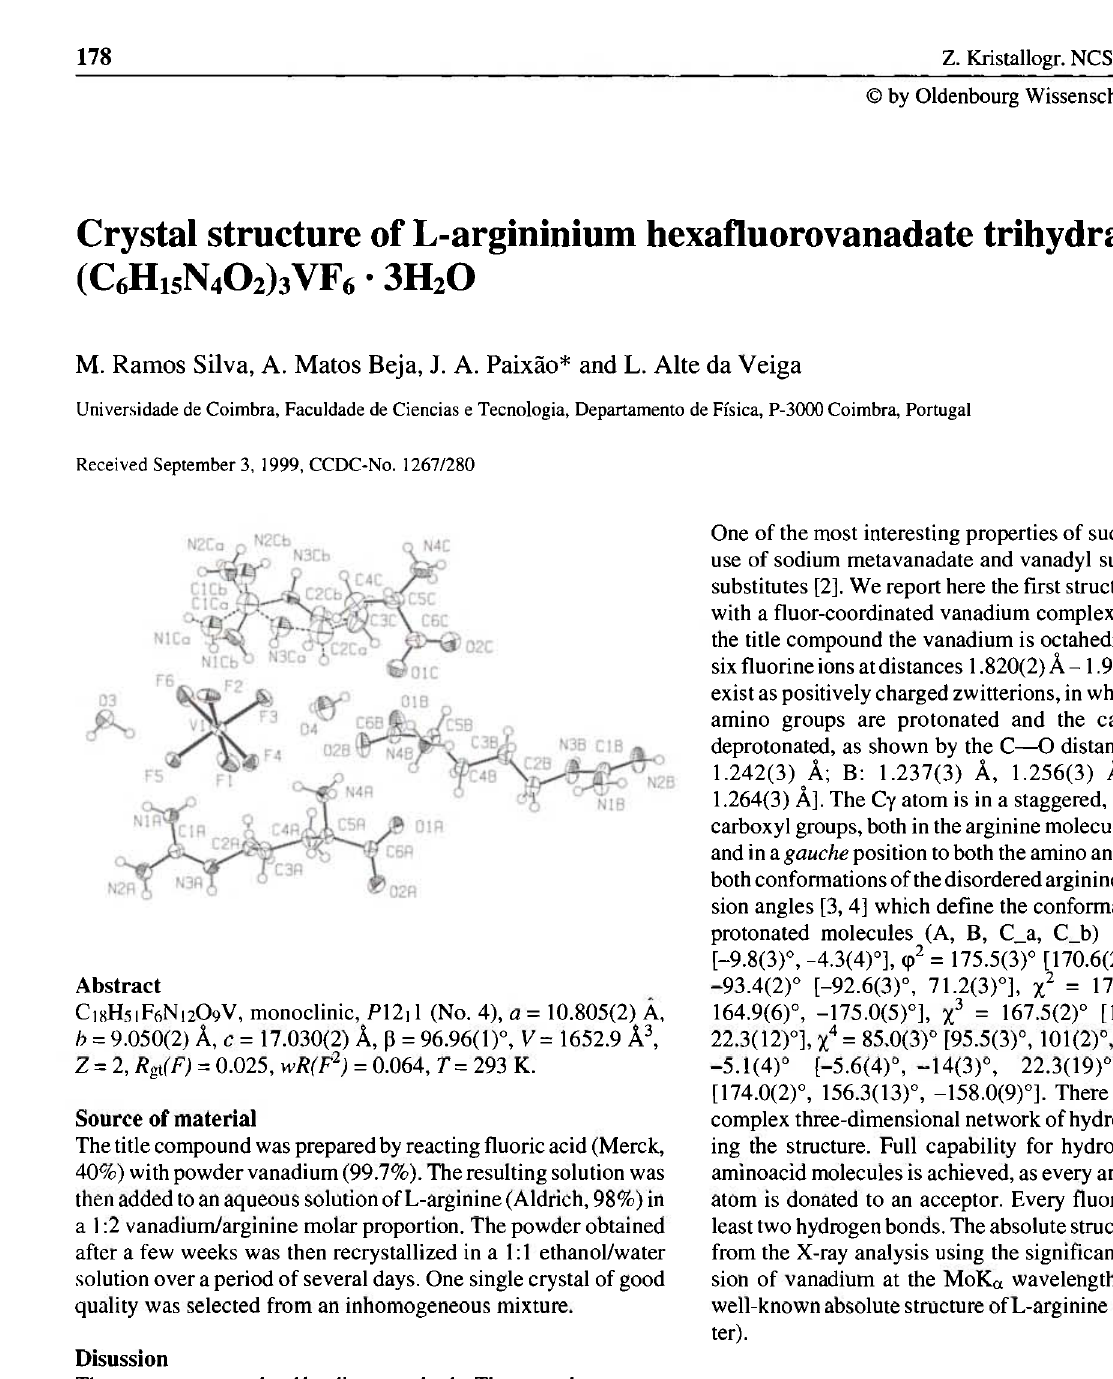
Table 1. Data collection and